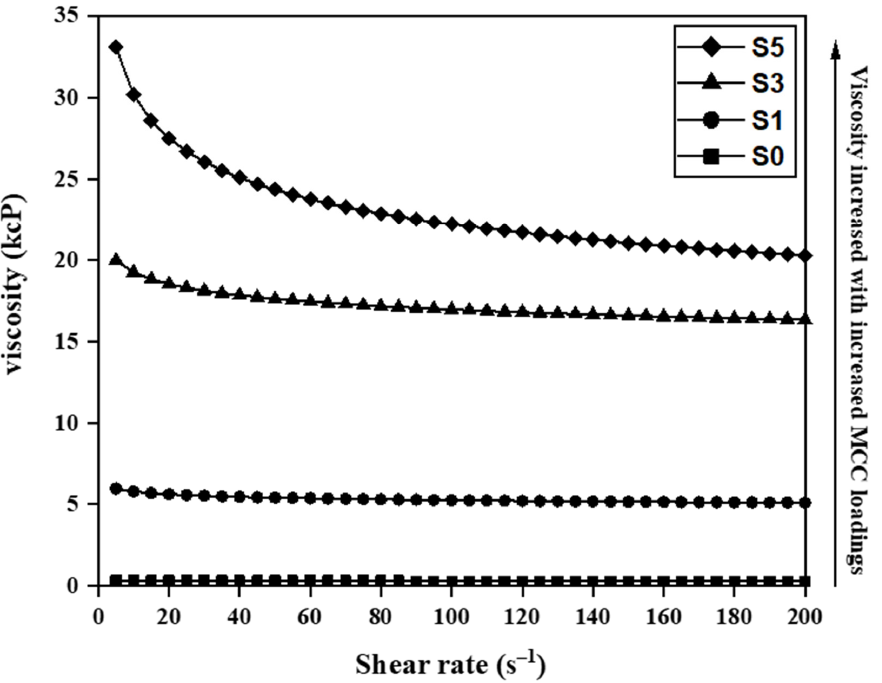
Figure 4. Viscosity of casting solutions for pristine PES (S0) and MCC-incorporated PES membranes with 1 wt.% (S1), 3 wt.% (S3), and 5 wt.% (S5) MCC loadings.